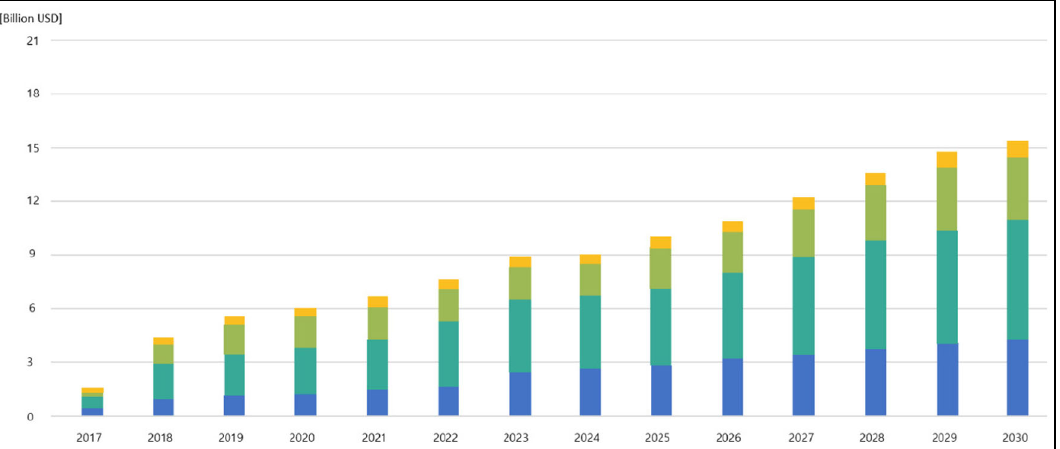
Figure 2. Market increase in electrical propulsion ships [16].